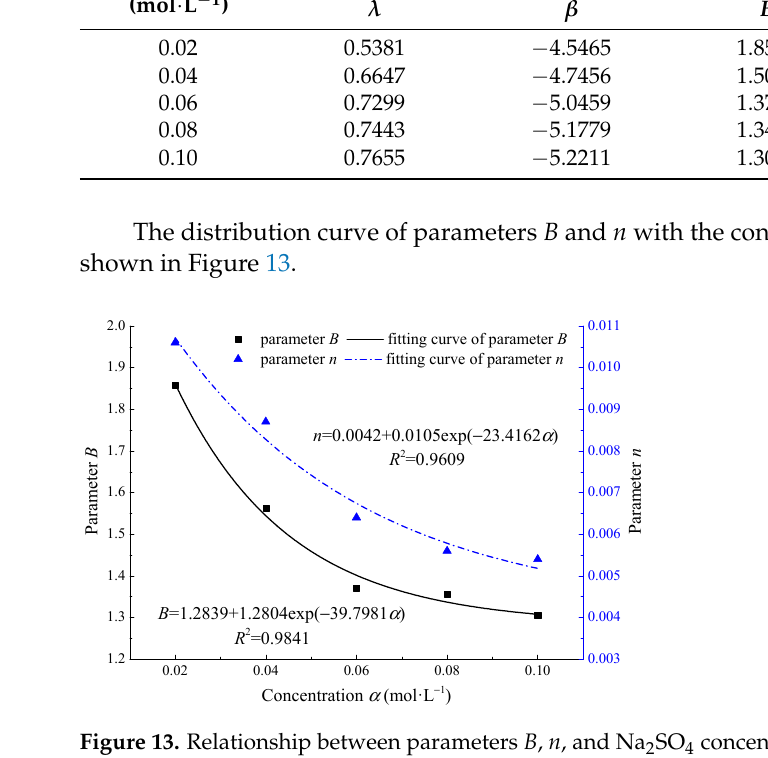
Figure 13. Relationship between parameters B , n , and Na 2 SO 4 concentration α . The parameters B and n decreased gradually with the concentration α . By fitting the